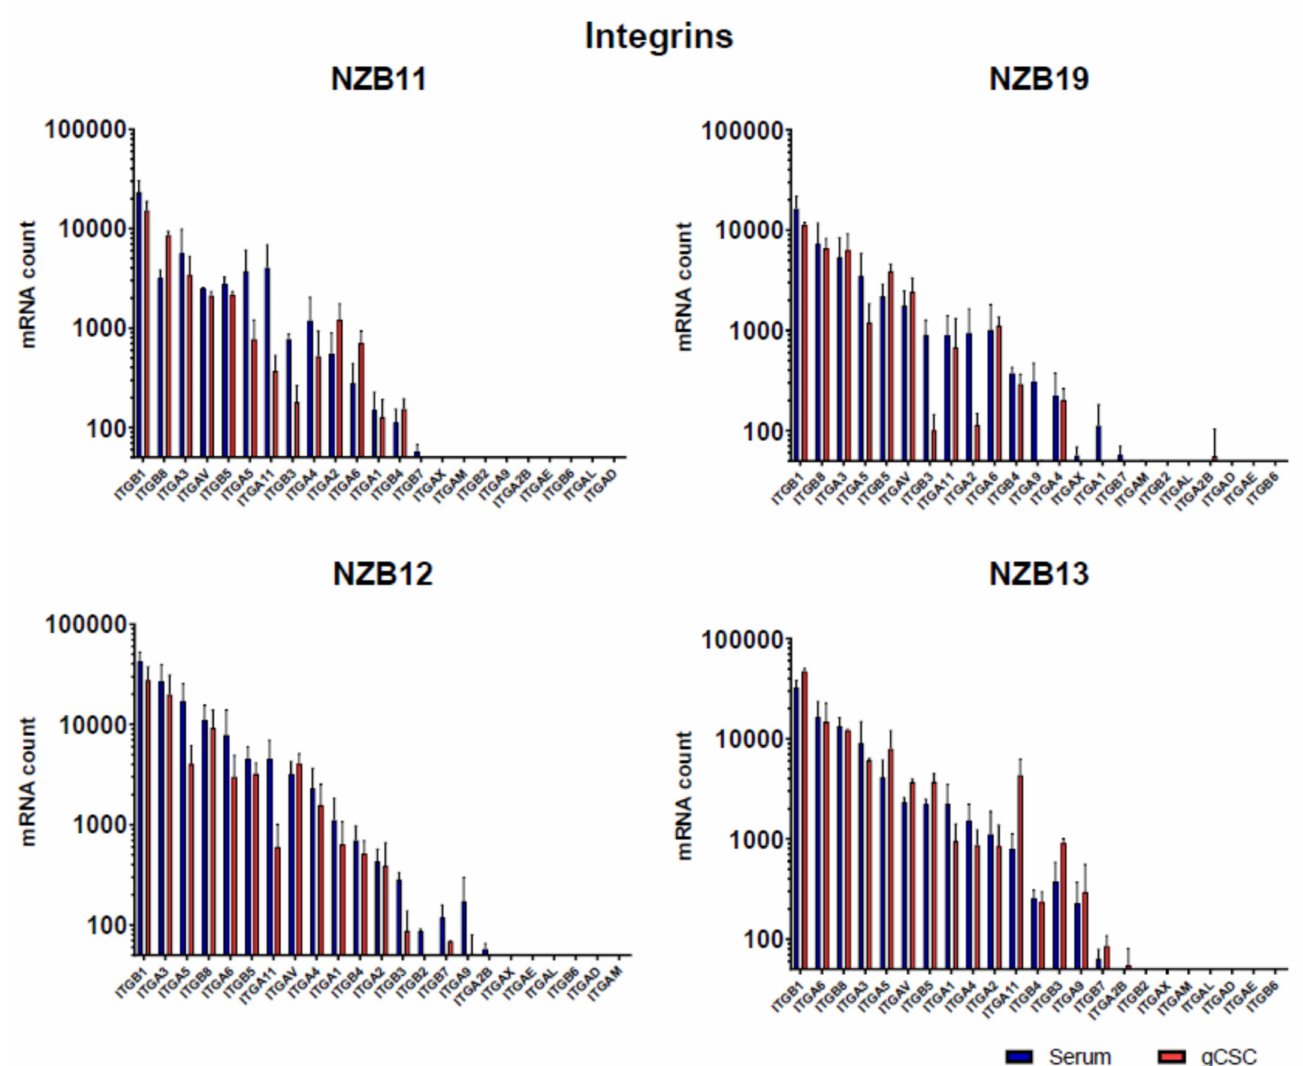
Figure 8. Integrin gene expression by glioblastoma serum-derived and gCSC cells. NanoStringTM analysis of absolute mRNA count in NZB11, NZB19, NZB12, and NZB13 serum-derived and gCSC GBM lines. The results of two independent experiments are shown. Unpaired students t-test analysis was carried out as a comparison of the serum vs gCSC mRNA count where p -value ≤ 0.05. None of the comparisons for any of the genes were